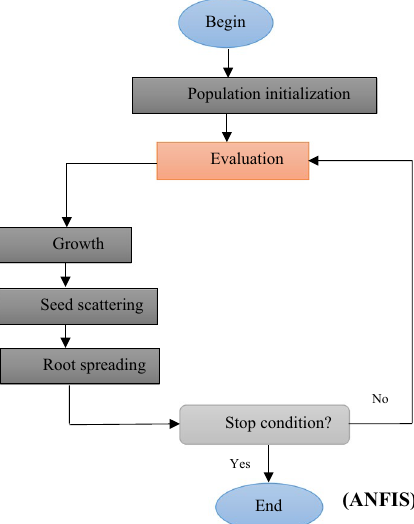
Fig. 3 Flowchart of TGO algorithm